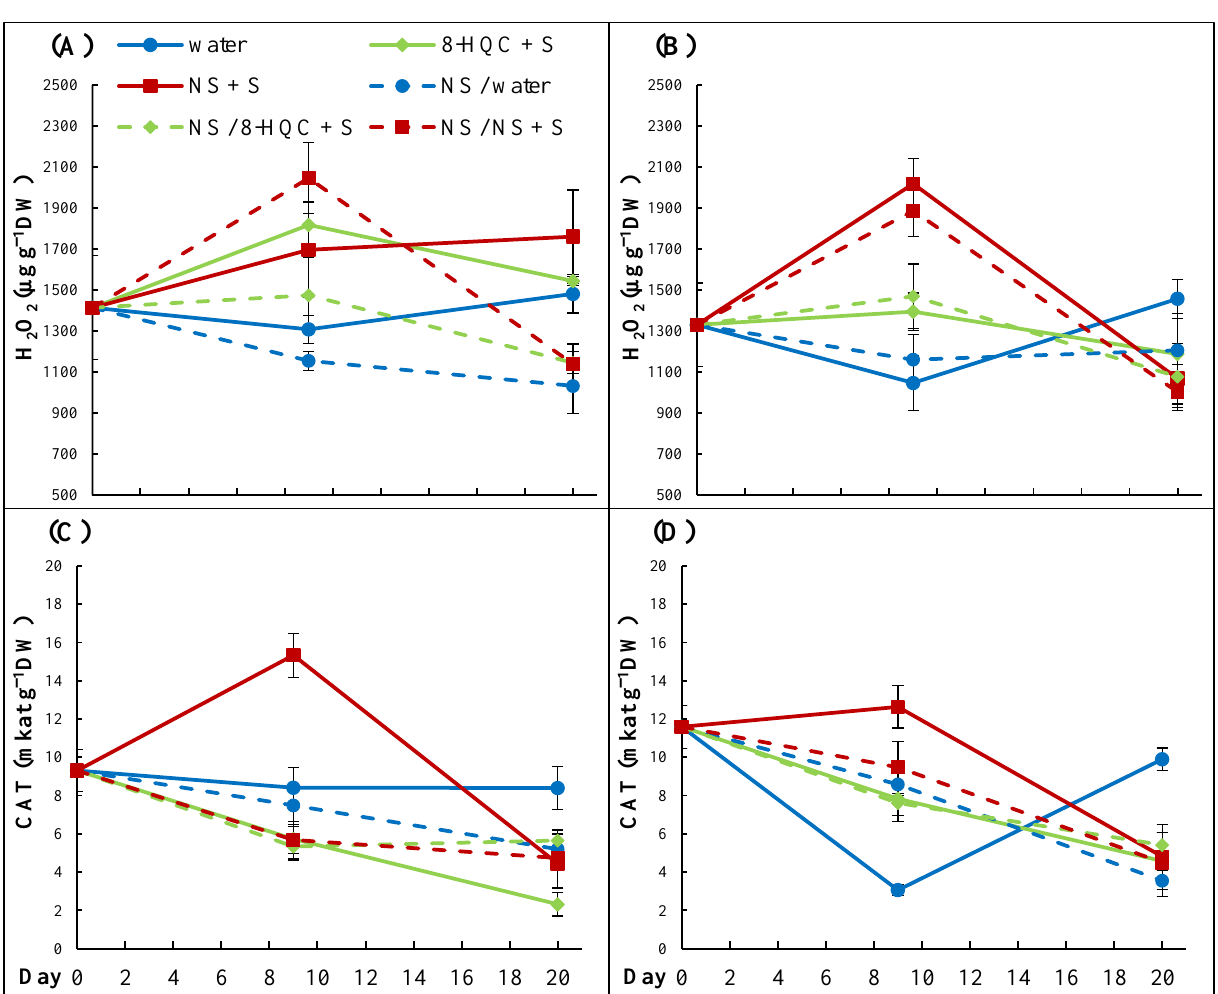
Figure 4. Hydrogen peroxide (H 2 O 2 ) content ( A , B ) and catalase (CAT) activity ( C , D ) in the lower ( A , C ) and the upper ( B , D ) flowers of cut lisianthus. Values are expressed as the mean ± SD. Vertical bars represent standard deviations of the means.